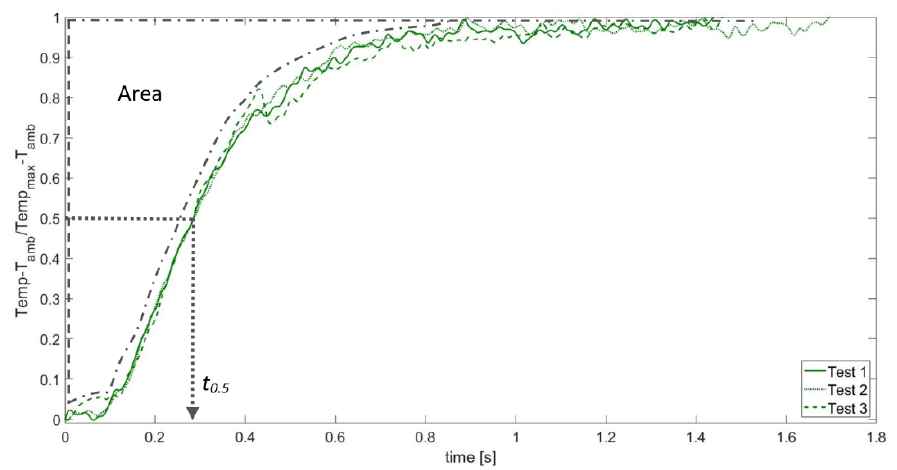
Figure 15. SPS: normalized temperature rises and standard parameters [15,17].